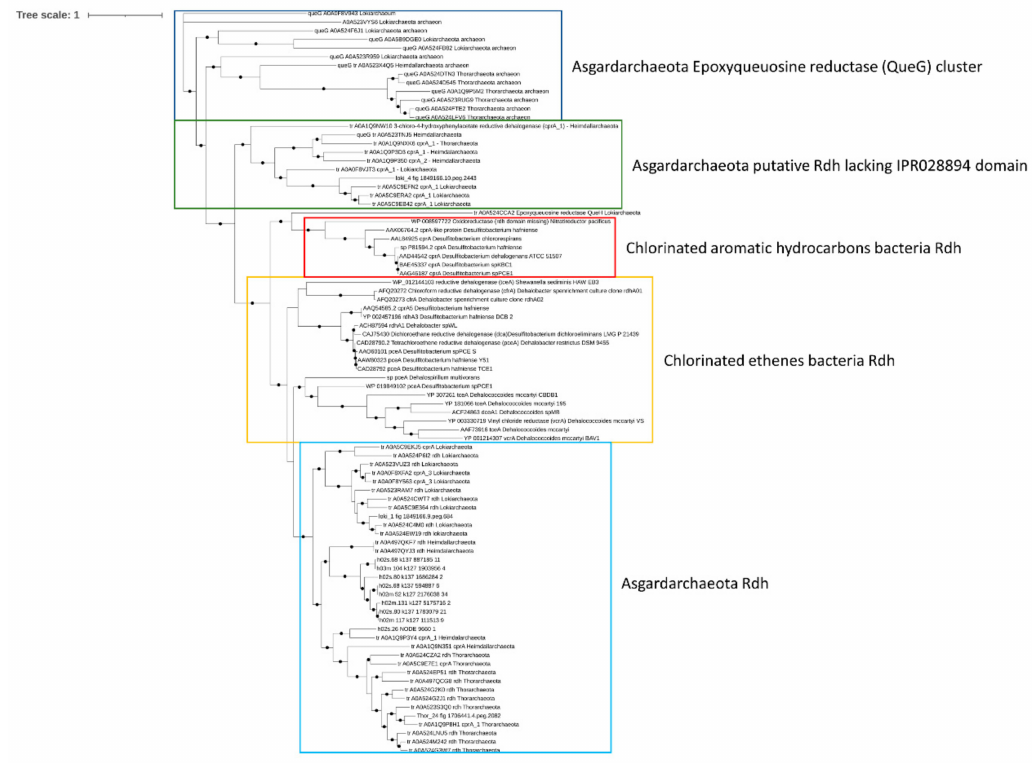
Figure 6. Phylogenetic tree of putative reductive dehalogenase (Rdh) in Thor_24, Loki and Heim bins, and Asgardarchaeota. Only nodes supporting a bootstrap value above 0.7 are shown. GenBank accession numbers and Uniprot accession numbers are shown. Epoxyqueuosine reductases (QueG) from Asgardarchaeota were used as an